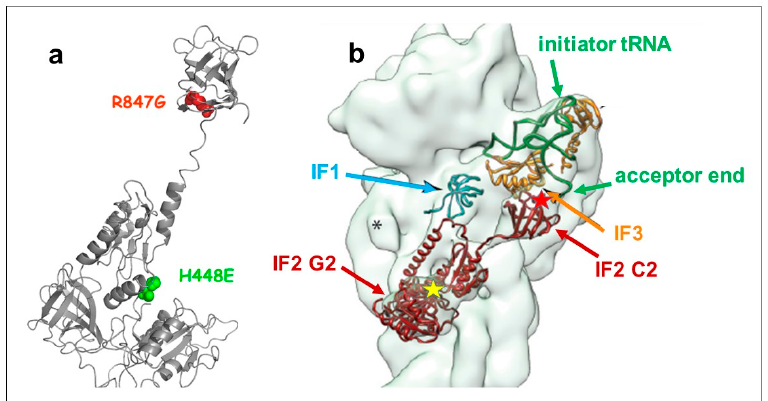
Figure 1. Location of the amino acid substitutions within the IF2 molecule. ( a ) Location of the His448 (green) mutation in the G2 domain and the Arg847 mutation (red) in the C2 domain of E. coli IF2. Because the C2 domain was not visible in the X-ray structure of bacterial IF2 [3,24], the positions of these amino acids are shown within the 3D structure of aIF5B, the archaeal IF2 homo- logue of IF2 [34]; ( b ) location of His 448 (yellow star) and Arg847 (red star) in the IF2 molecule (brown) within a 30S initiation complex with respect to the location of the acceptor end of initiator tRNA (green) and of initiation factors IF1 (cyan) and IF3 (orange). The positions of the 30S (gray) ligands are derived from cryo-EM reconstitutions [14]. Histidine 84 of elongation factor EF-Tu was mutagenized in E. coli [35,36] and Thermus thermophilus [37] and, depending upon the nature of the substitution, were shown to have unaltered GTP binding, but a drastically reduced GTPase activity. Re- placement with Glu, Gln, and Gly of the corresponding His448 in E. coli IF2 generated mutants also defective in GTP hydrolysis and displaying a dominant lethal phenotype [38,39]. Identical results were obtained upon substitution of His301 of G. stearothermoph- ilus IF2 with Ser, Leu, and Tyr, whereas substitutions with and Gln and Arg did not result in a dominant lethal phenotype in spite of the loss of GTPase activity displayed upon His substitution with Arg [40,41]. The dominant lethal phenotype occurring when His448 of E. coli IF2 was substituted with Glu in an extra chromosomal copy of infB can be observed in the experiments shown in Figure 2. After induction of expression of this mutated gene, despite the presence of a wild type copy of infB in the chromosome, the cells stopped growing (Figure 2a) and a rapid and drastic reduction of the number of viable cells ensued (Figure 2b).